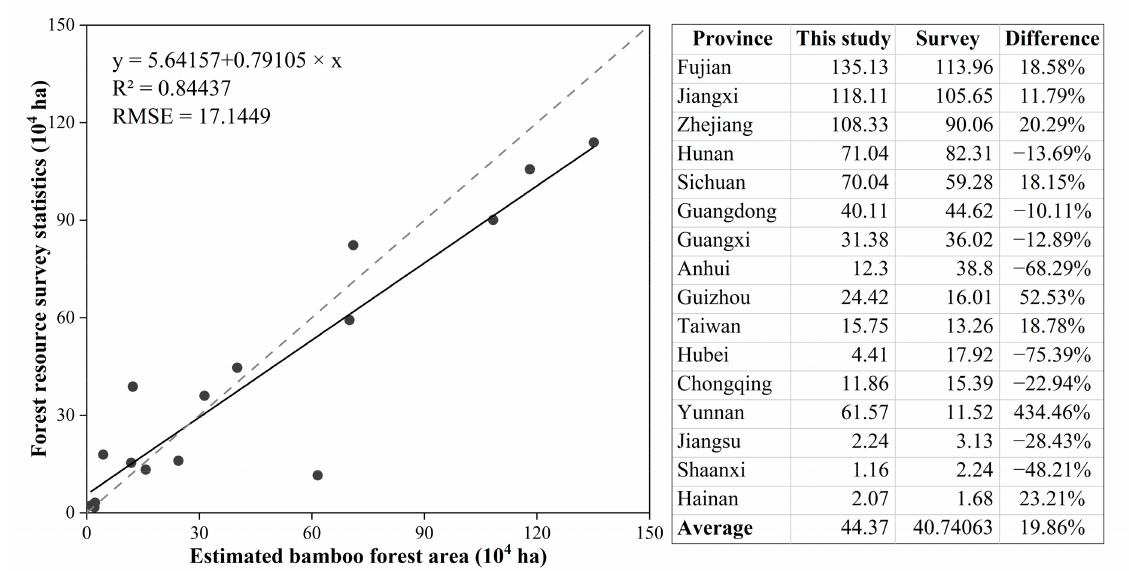
Figure 6. Scatter plot of the comparison between the reference and estimated results of the bamboo areas at the provincial level. The solid line is the fitting line between reference and estimated results, and the mathematical meaning of the dotted line is y =